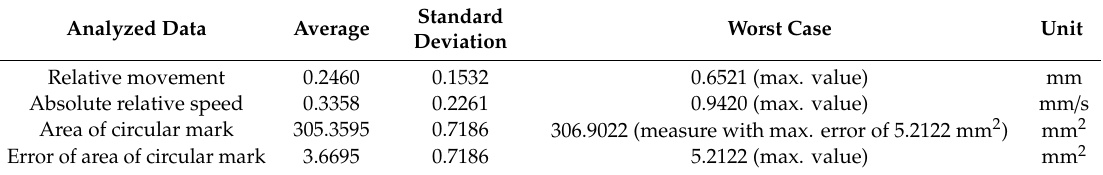
Table 3. Comparison between the proposed IIIR and other existing methods /